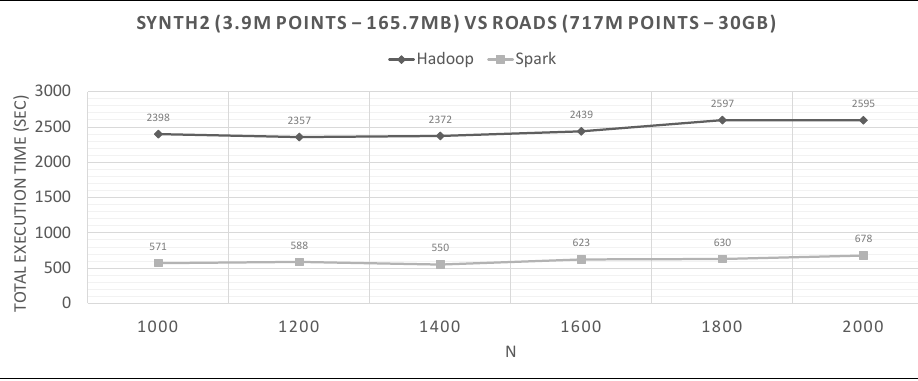
Figure 25. Hadoop vs. Spark, large synthetic query and large training datasets. Finally, Figures 26 and 27 show how the real query dataset, in both default and new locations, behaves against the large